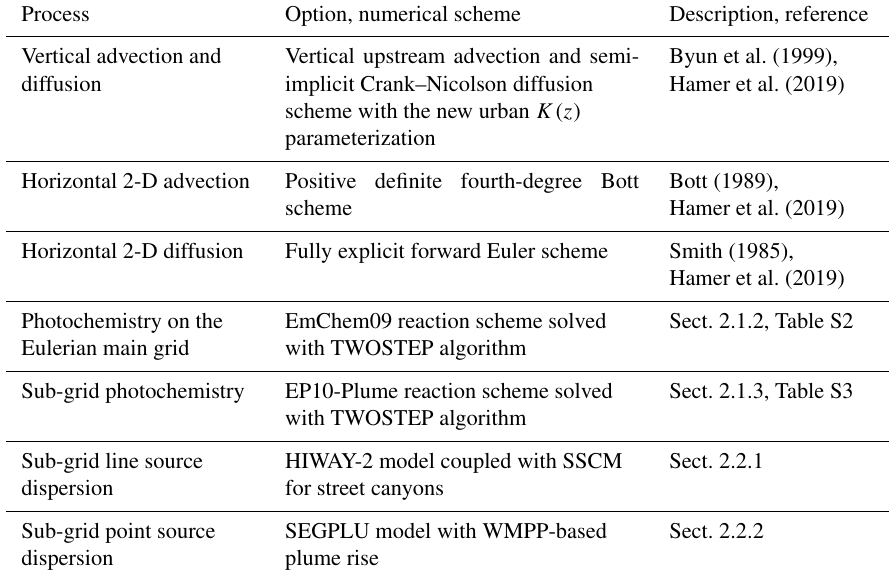
Table 1. The configuration of EPISODE–CityChem model processes in the AQ simulations for Hamburg.